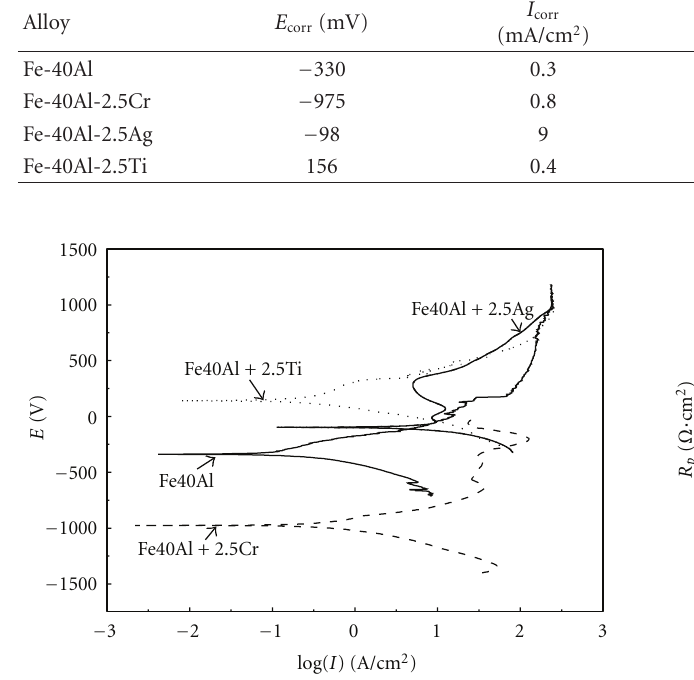
Figure 3: Polarization curves for Fe40Al alloyed with 2.5% Cr, Ti, and Ag in the KCl + ZnCl 2 mixture at 670 ◦ C.